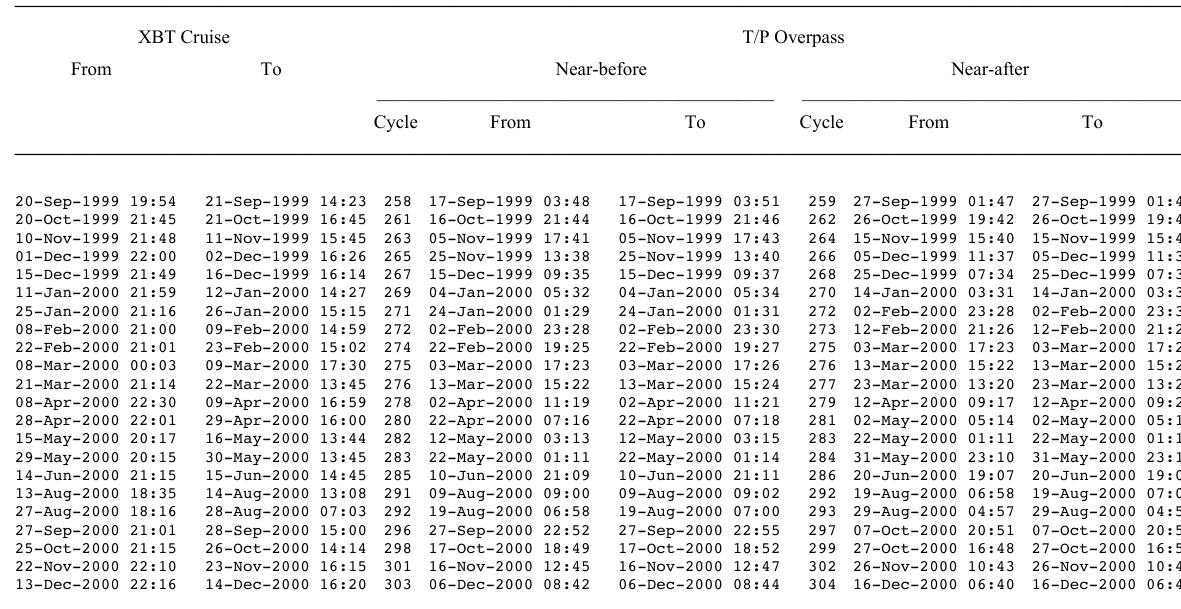
Abbreviations are : XBT , e X pendable BathyThermograph; T/P ,